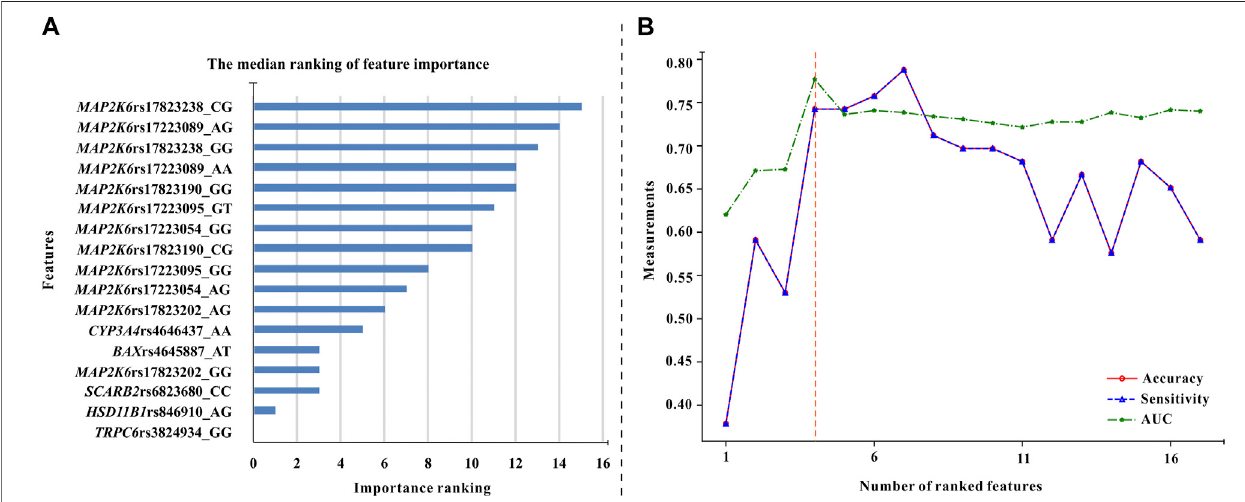
FIGURE 2| The procedure of feature selection. (A) The median values offeatureimportance ranking (each variable has 16ranking values). The smaller the median value,themoreimportantthevariable (B) Theoverallvariationofaccuracy,sensitivity,andAUCofthemodelsusedforexcavatingtheoptimalfeaturecombination.These models were generated by the XGBoost algorithm and fi ve-fold cross-validation. Each variable was added to the models in turn (Starting from the variable with the highestmedian valuesuntilallvariableswereaddedtothemodels). Itcanbeseenthatthemodelbuiltbythe fi rstfourvariableshasthebestAUCandrelativelyhigh accuracy and sensitivity values. Therefore, these four variables (TRPC6 rs3824934_GG, HSD11B1 rs846910_AG, MAP2K6 rs17823202_GG, and SCARB2 rs6823680_CC genotypes) are the optimal feature